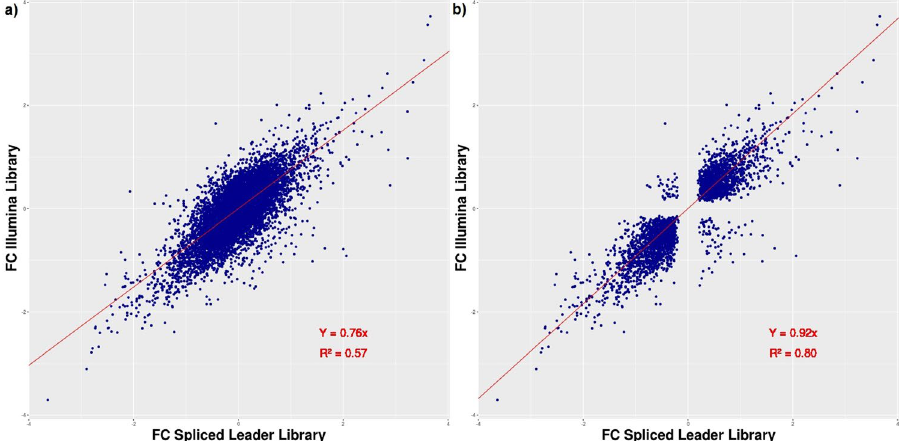
Figure 4. Correlation between log2 fold change obtained from sequencing with SL-seq versus Illumina stranded mRNA library prep. ( a ) All genes are plotted for which counts were obtained in both library preps. ( b ) Only genes plotted that had a significant LOG-STAT fold change (DESEQ2 adjusted p < 0.05) with both SL-Seq and